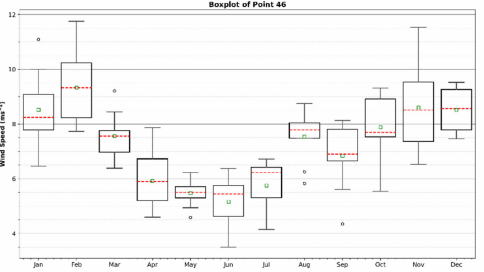
Figure 5. Boxplots for monthly wind speed values at hub height in the Lemnos Plateau (point